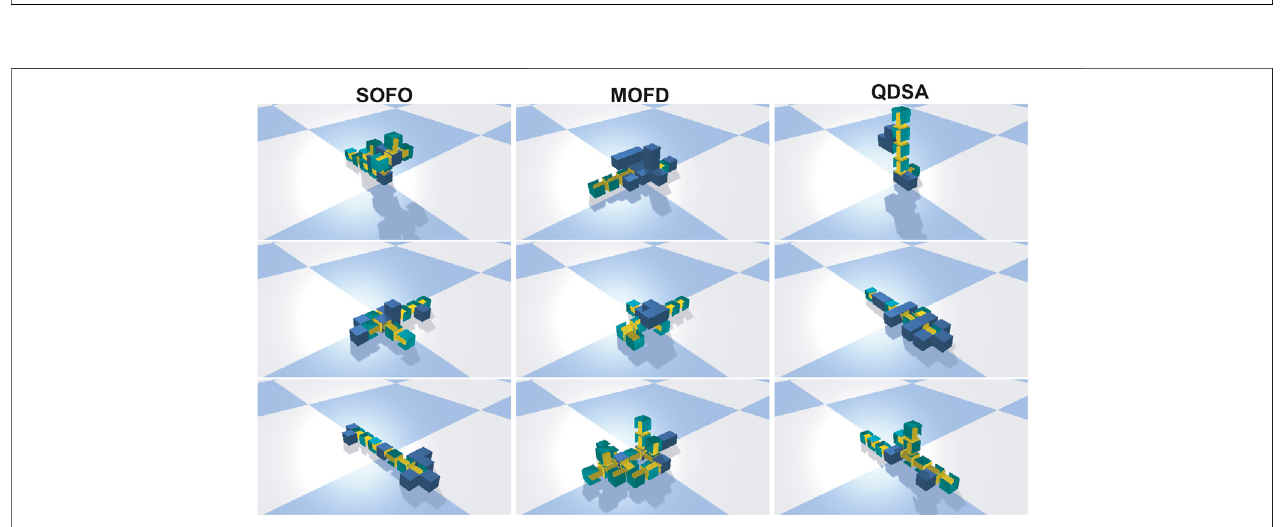
FIGURE7| Thebestsolutionfoundinthethreebestrunsofevolutionforeachsearchalgorithm.Videosofthesemorphologiescanbefoundonthesupplementary material page.